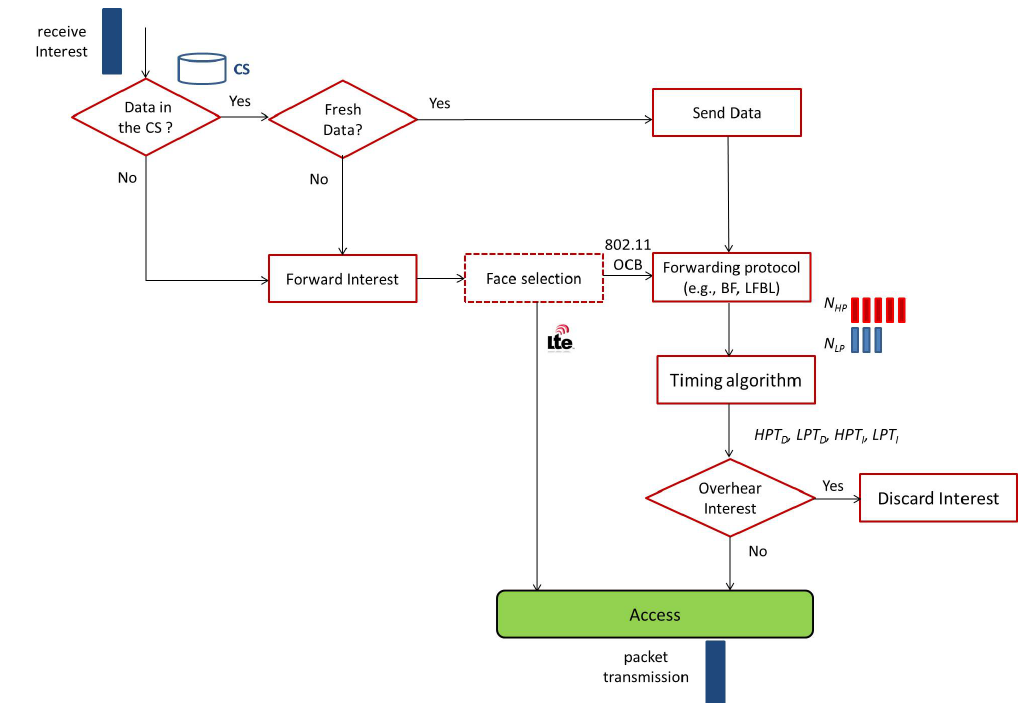
Figure 4. Interest processing at an intermediate vehicle